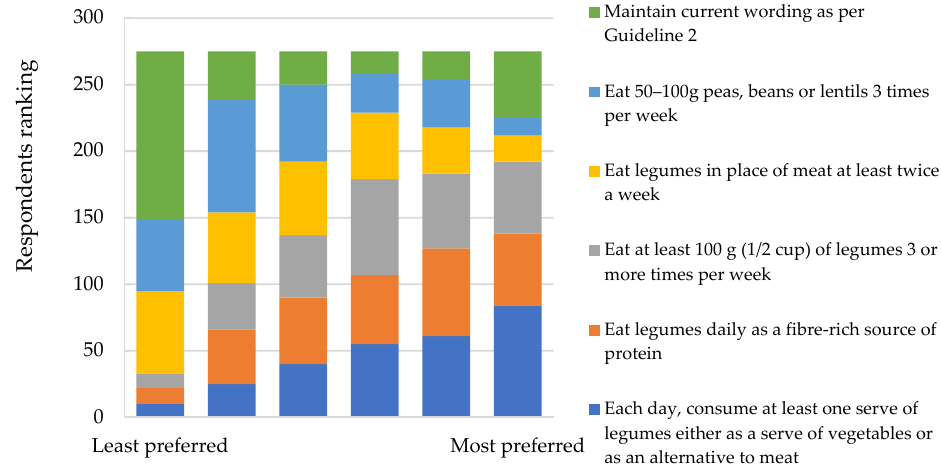
Figure 1. Ranking of preferred new guideline statements for the promotion of legume intake ( n = 275).